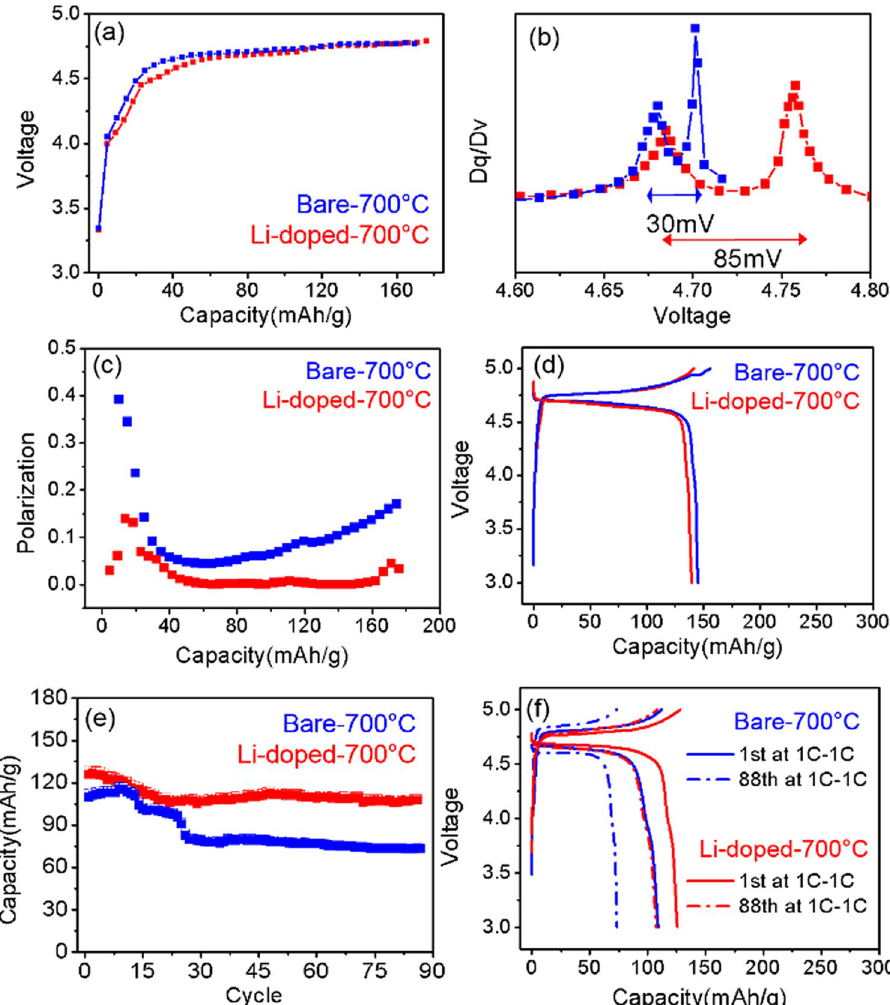
Figure 4. ( a ) Open circuit voltage (OCV) profiles from GITT measurement ( b ) Differential capacity plot (dV/ dQ) of the bare − 700 °C and the Li-doped − 700 °C sample ( c ) Polarization during charging ( d ) Voltage curve at C/5 rate and ( e ) Capacity retention ( f ) Voltage curves at 1C-1C rate for the bare − 700 °C sample and the Li- doped − 700 °C